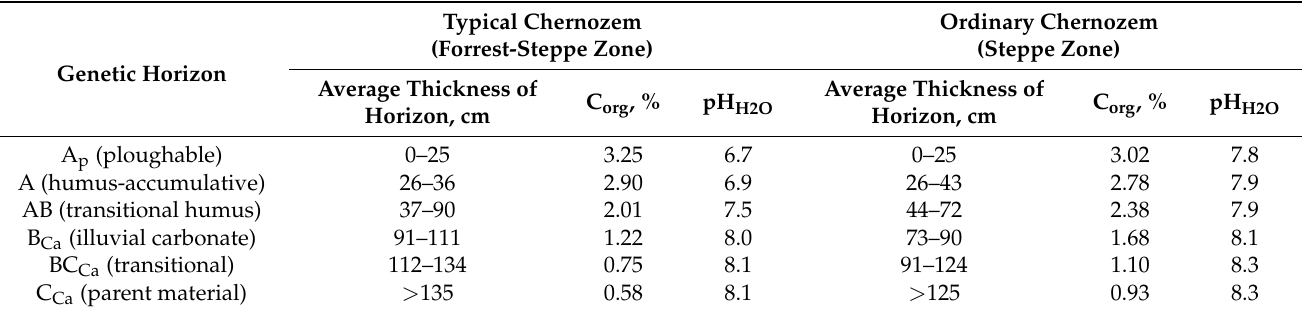
Table 2. Average content of C org and the pH H2O value in soil profiles of arable chernozems of typical and